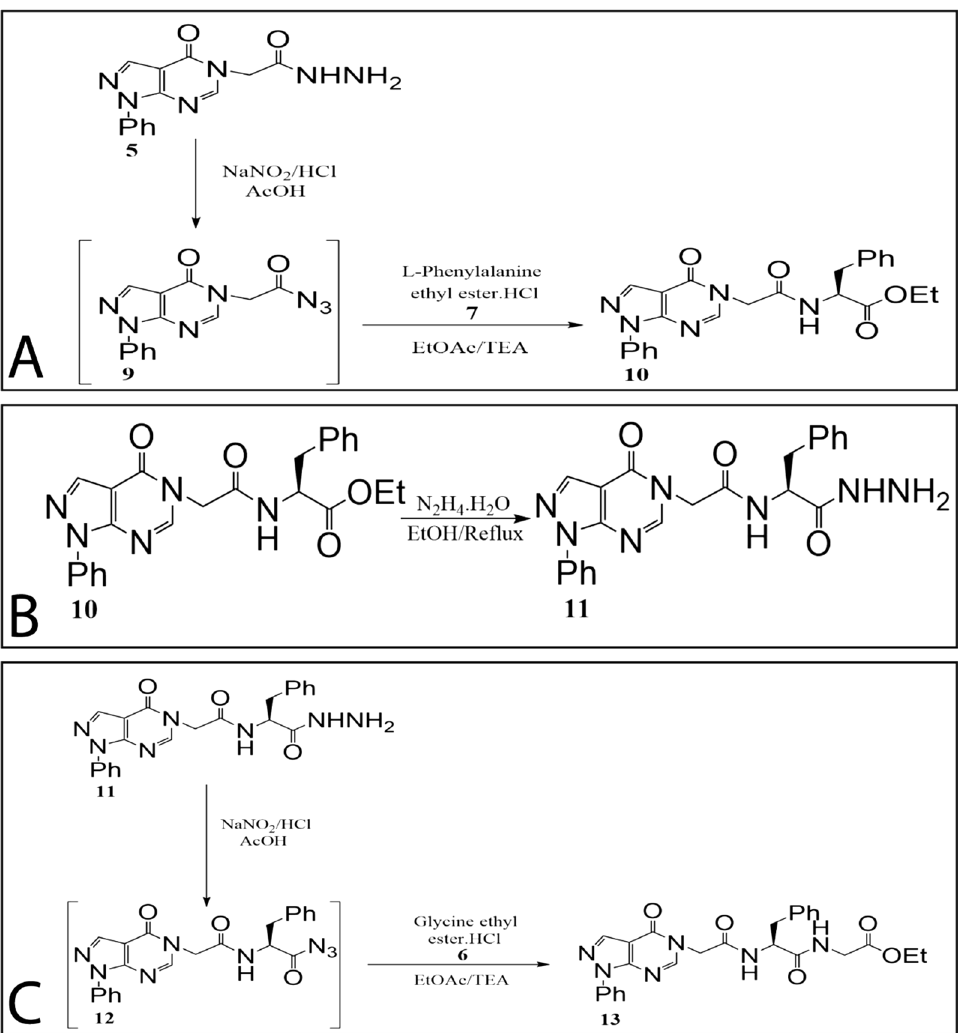
Fig. 6 Synthesis of compounds 10 , 11, and